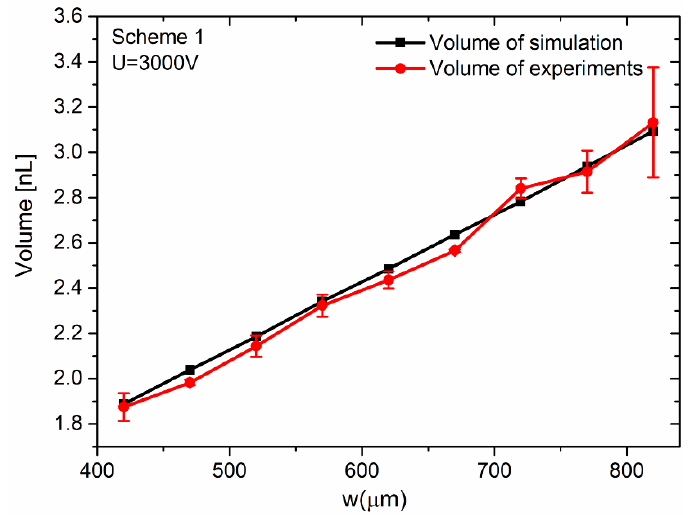
Figure 6. The volume of the droplet in simulation and experiments under the voltage of 3000 V in scheme 1. The w = 420, 470, 520, 570, 620, 670, 720, 770, and 820 µ